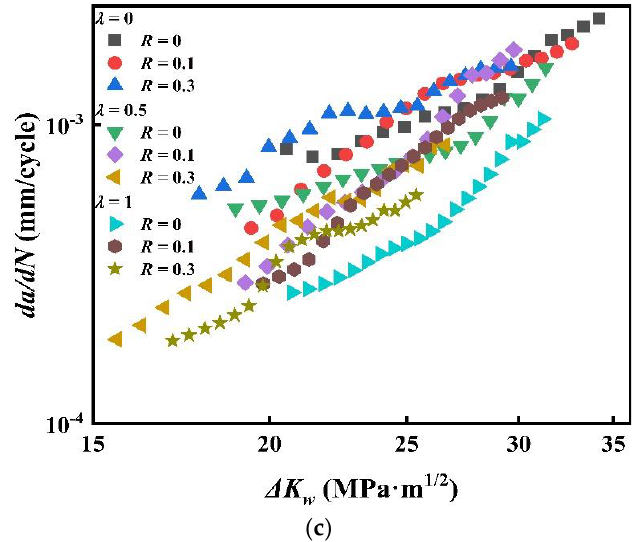
Figure 16. The relationship between ∆ K I and da / dN, based on the Walker model. ( a ) β = 90° ( b ) β = 60° ( c ) β = 45°.